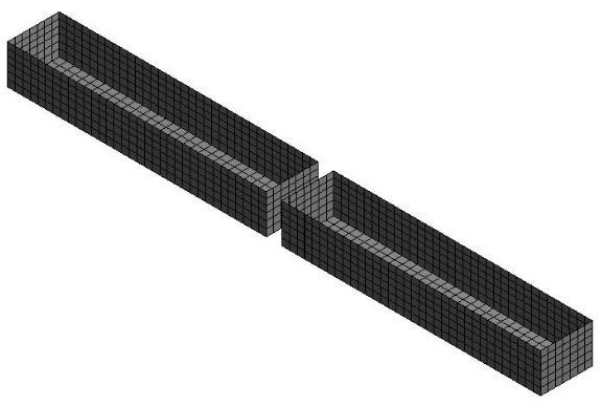
Figure 7. Hydrodynamic model. In the ANSYS-AQWA platform, in order to simulate the hinged connection between floating bodies, a hinged joint is set between floating bodies, the horizontal axis rotation between floating bodies is released and the linear degrees of freedom are coupled, as shown in Figure